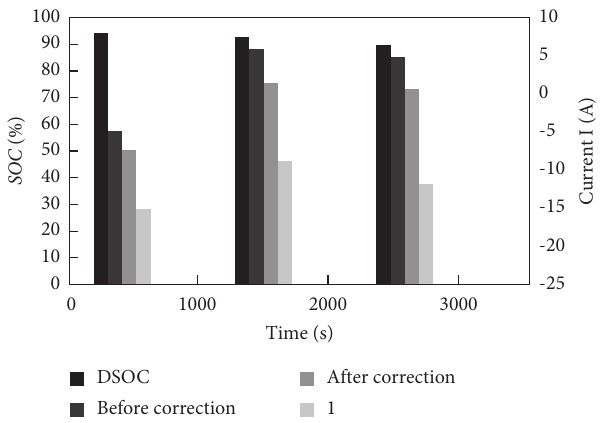
Figure 5: Comparison of SOC estimation before and after OCV- SOC curve correction.